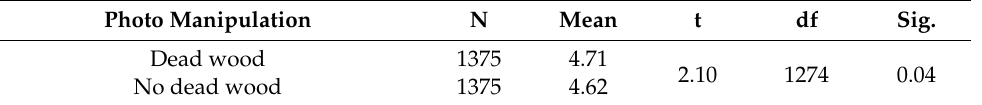
Table 3. The results of the paired t-test for the differences in preference for the environments with and without dead